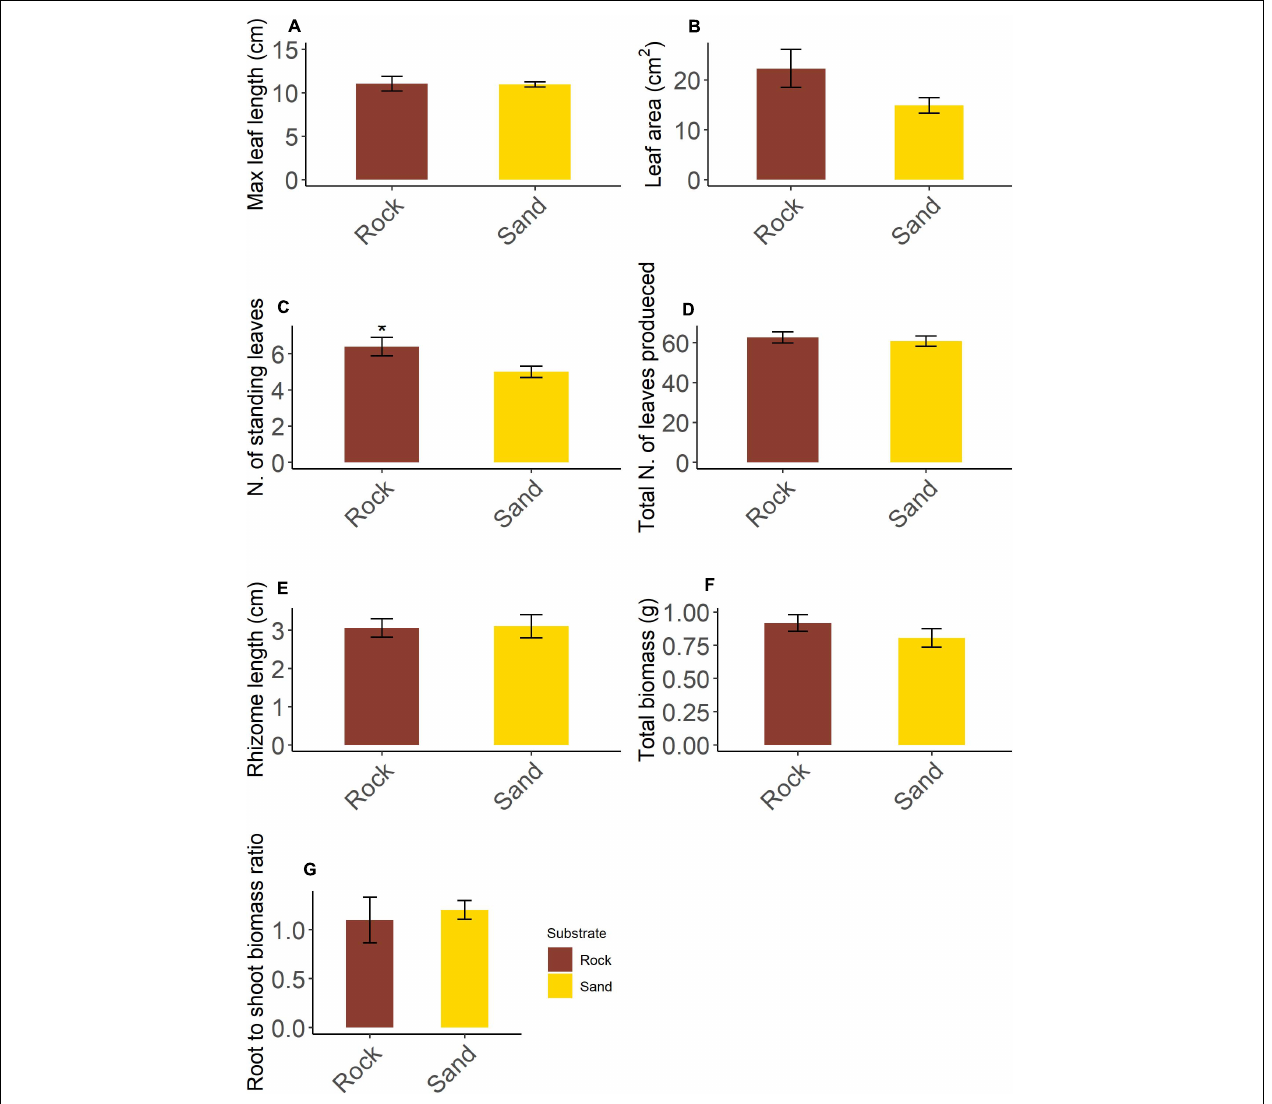
FIGURE 4 | Morphological and growth variables of five-year old Posidonia oceanica seedlings grown on rock and sand substrate (A–G) . Asterisk indicates a significant statistical difference at α < 0.05. Data are means ± SE; n =